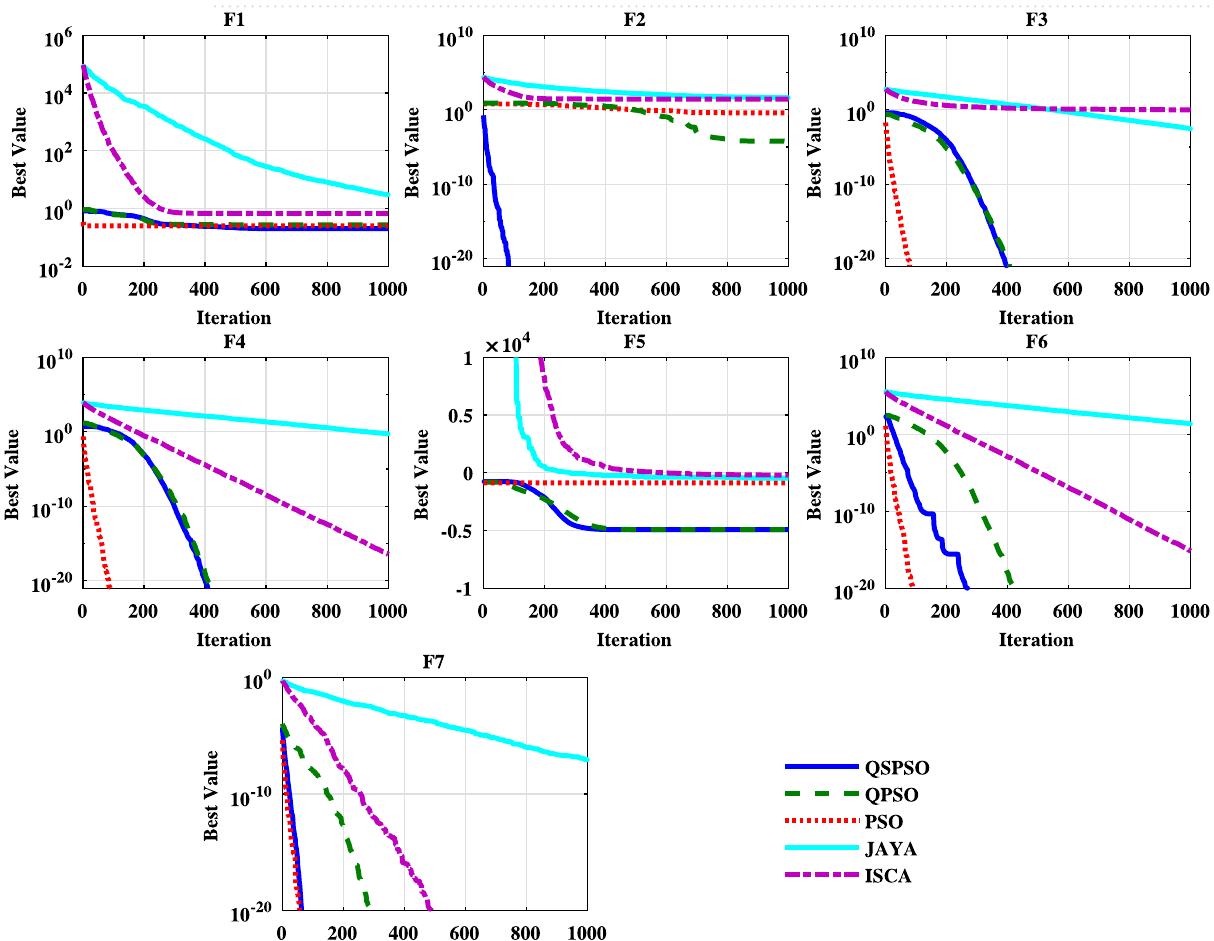
Figure 5. Convergence curves of the unimodal test